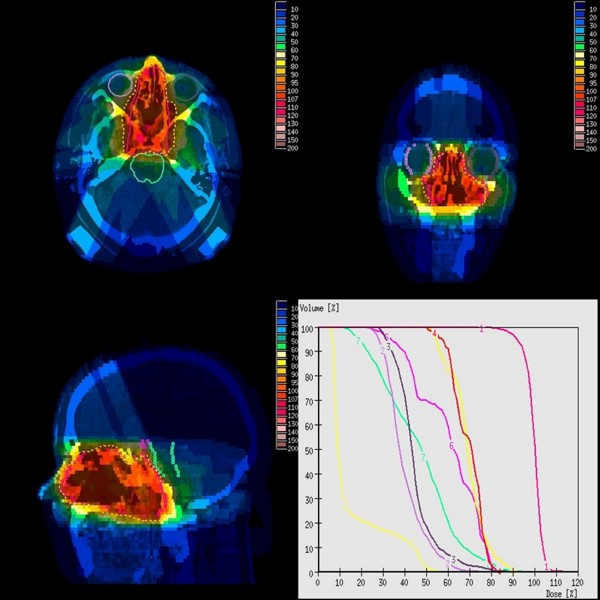
Transversal, coronar and sagittal dose distribution and DVH information in patient 3. graphs: PTV (1), left eye (2), right eye (3), right optic nerve (4), left optic nerve (5), chiasma (6), brainstem (7), spinal cord (8)